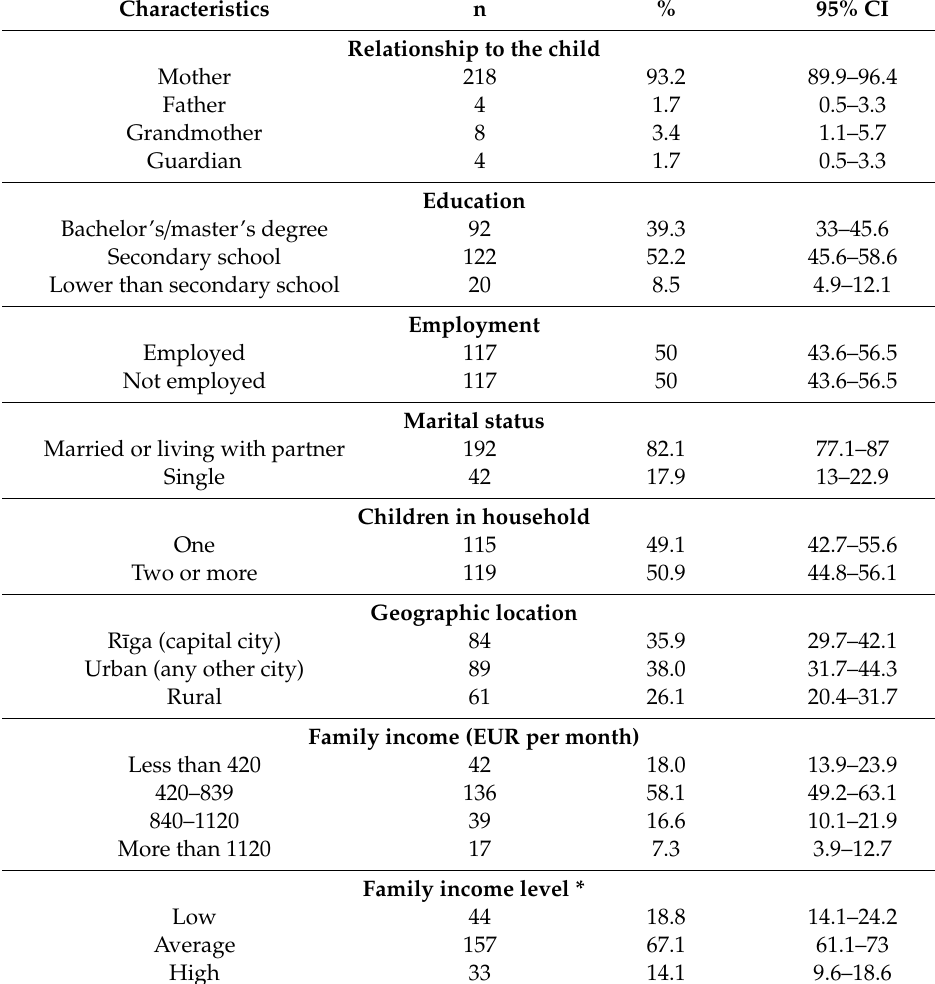
Table 4. Characteristics of participants and their